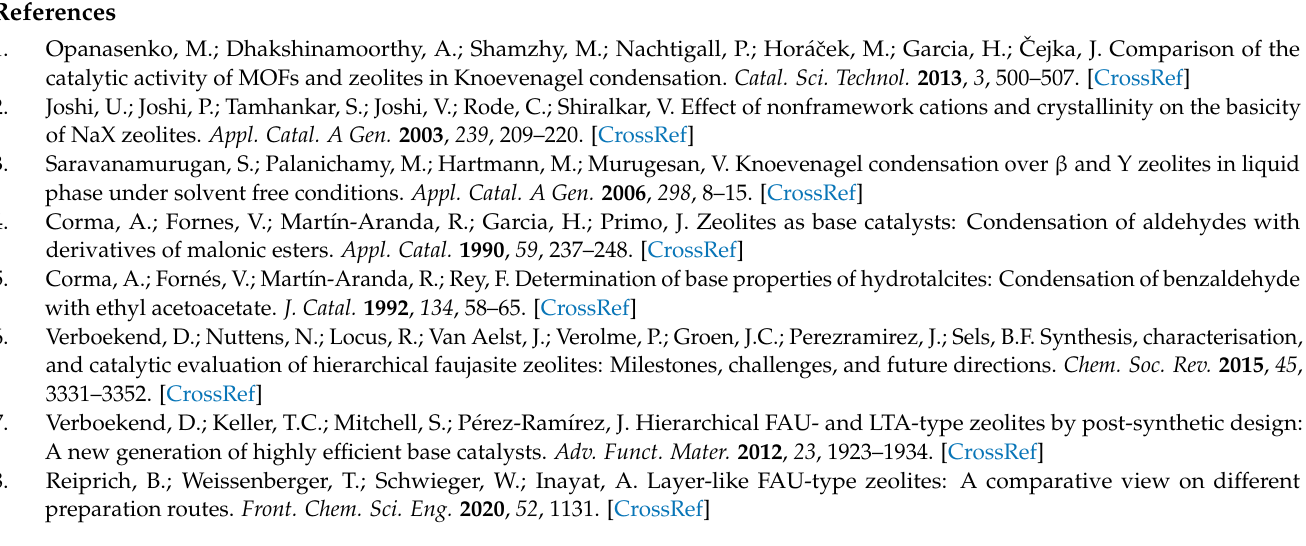
Table S1: Values used to estimate the required amount of sodium hydroxide solution for